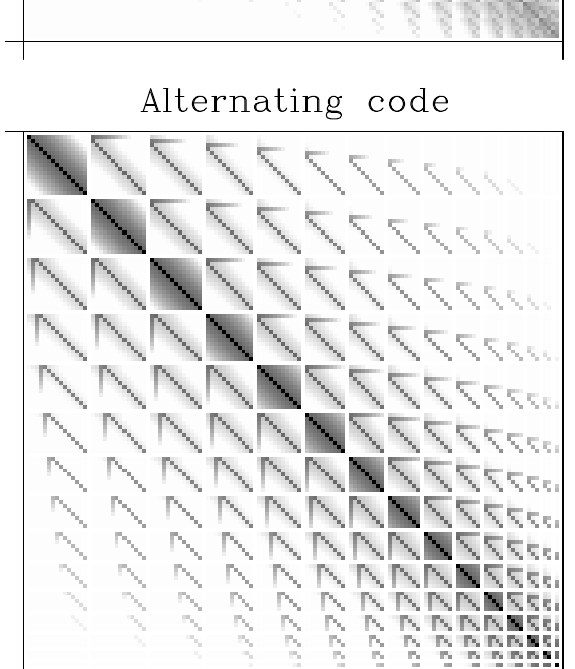
Fig. 1. Ambiguity functions W ts 1 ,ts 2 ( τ, r ) for a long-pulse experi- ment with a pulse 16 times the width of the sampling interval. Six- teen different ambiguity functions are actually plotted here, repre- senting sixteen different temporal lags. A small droop in transmitter power was assumed in calculating this figure.